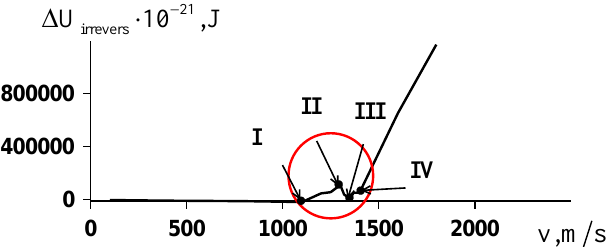
Fig. 1. Irreversible increment of potential energy versus the impact velocity for initial temperature T=0